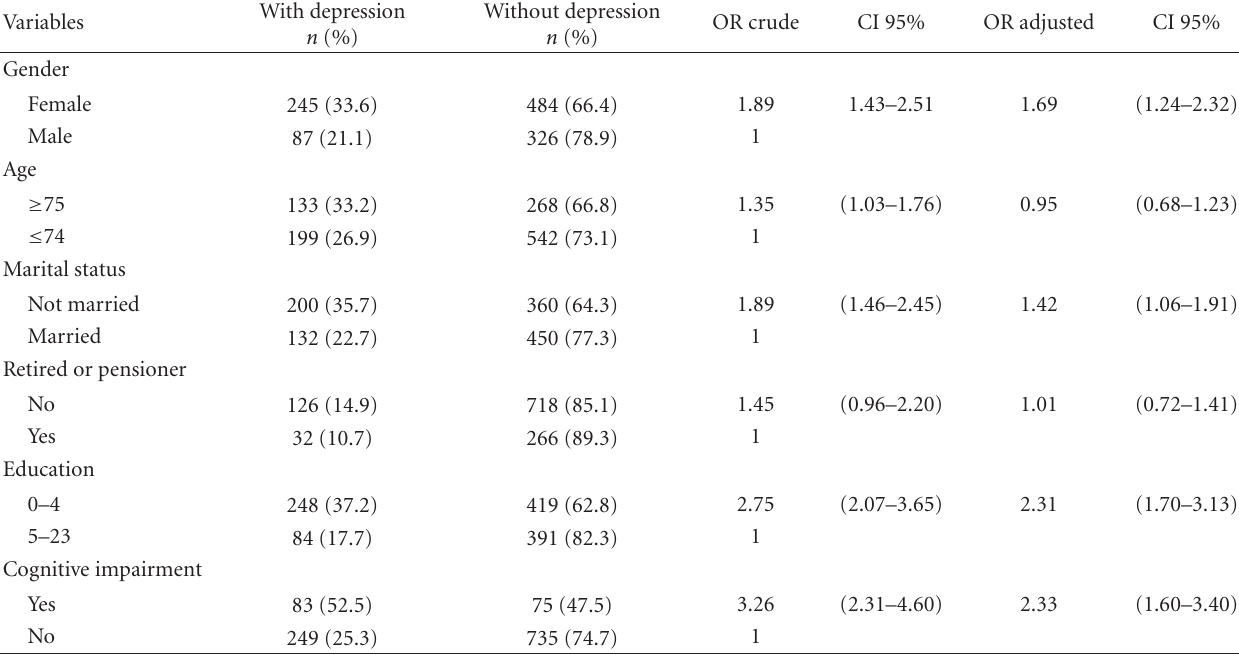
Table 4: Relationship between depression, sociodemographic data, and cognitive impairment ( n =